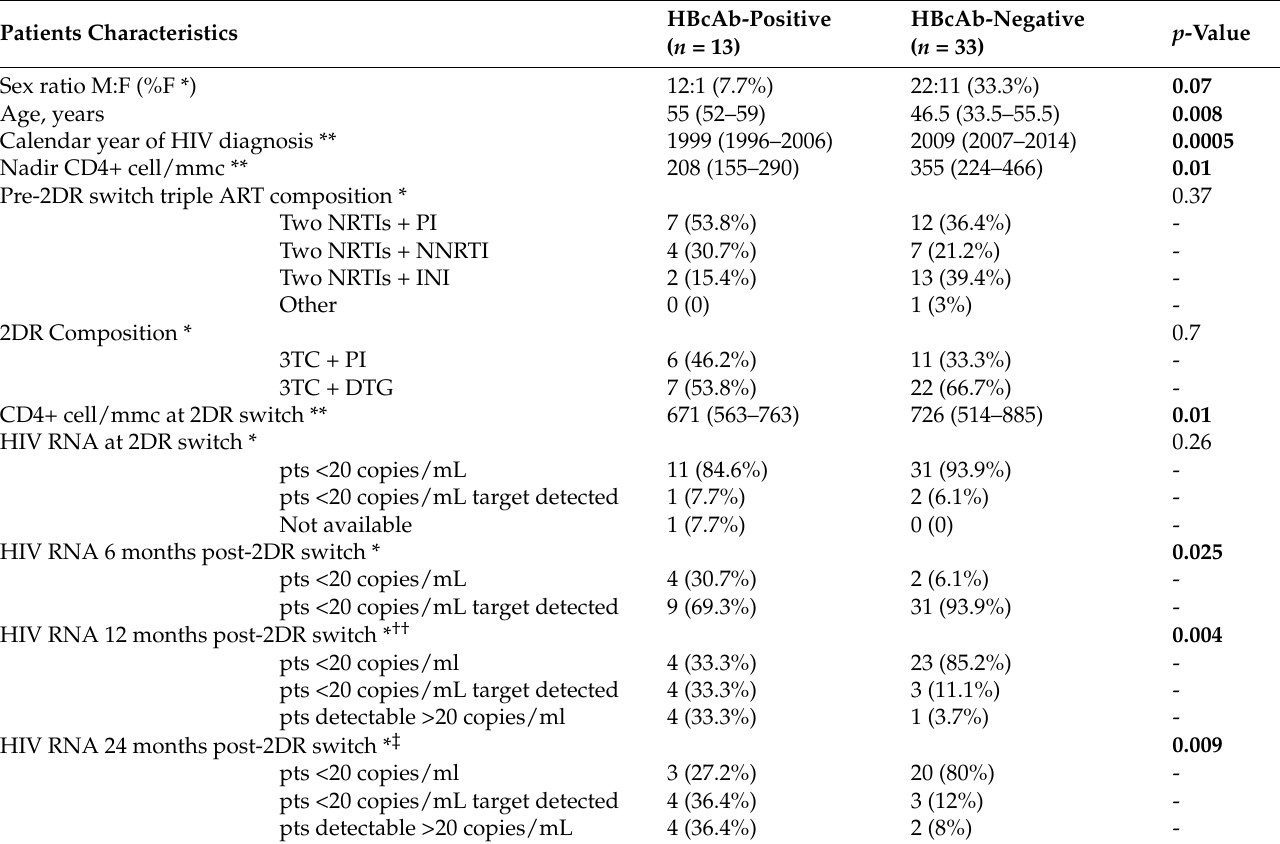
Table 3. Comparison of HIV-RNA values after the 2DR-3TC switch in the HBcAb-positive and HBcAb-negative groups, after 6 months (T6, n = 46), 12 months (T12, n = 39), and 24 months (T24, n = 36), and overall comparison of patients subgroup